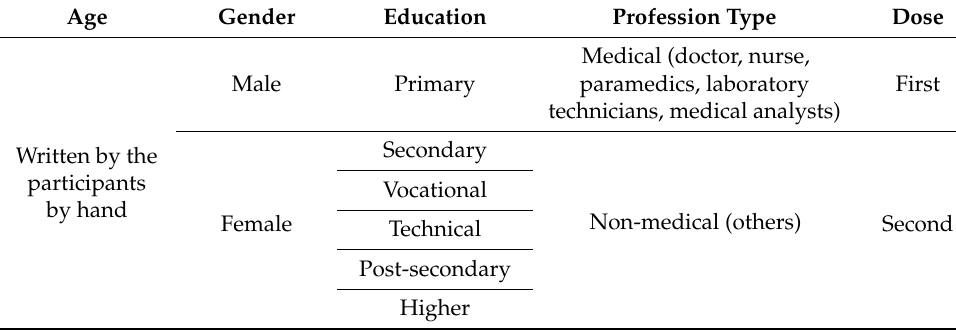
Table 2. Description of the used criteria.